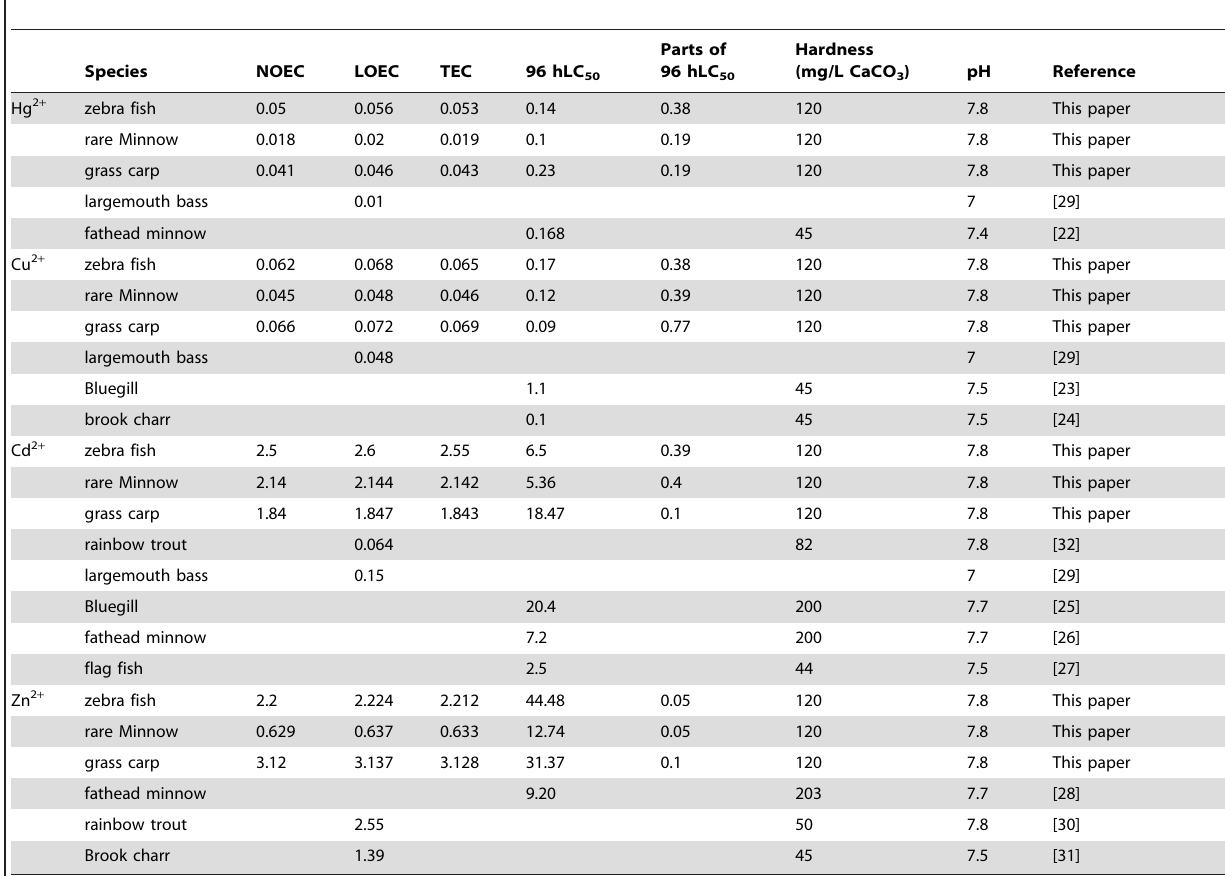
Table 2. Analysis of the acute toxicity, respiratory reaction and sensitivity of different fish